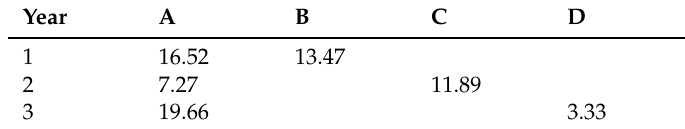
Table 3. Investment strategy (profit and risk are